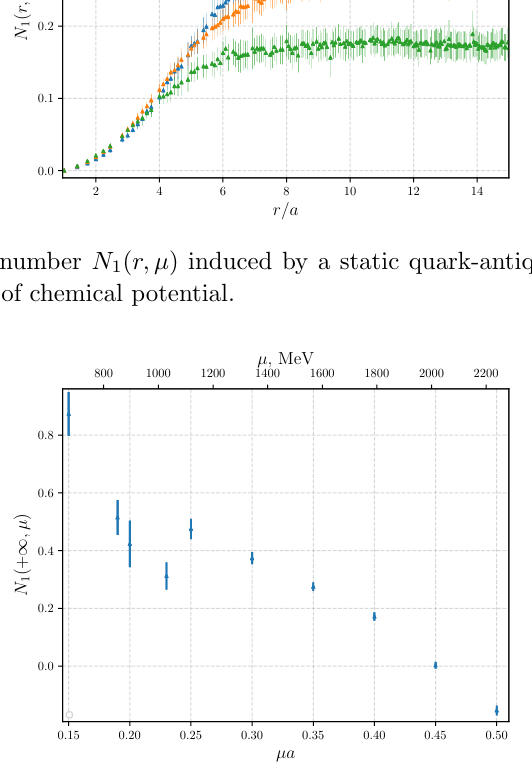
Figure 8 . The quark number N 1 ( r; (cid:22) ) at large distance as a function of chemical potential. Notice that the N ( r; (cid:22) ) is the quark number which arises in the system due to the